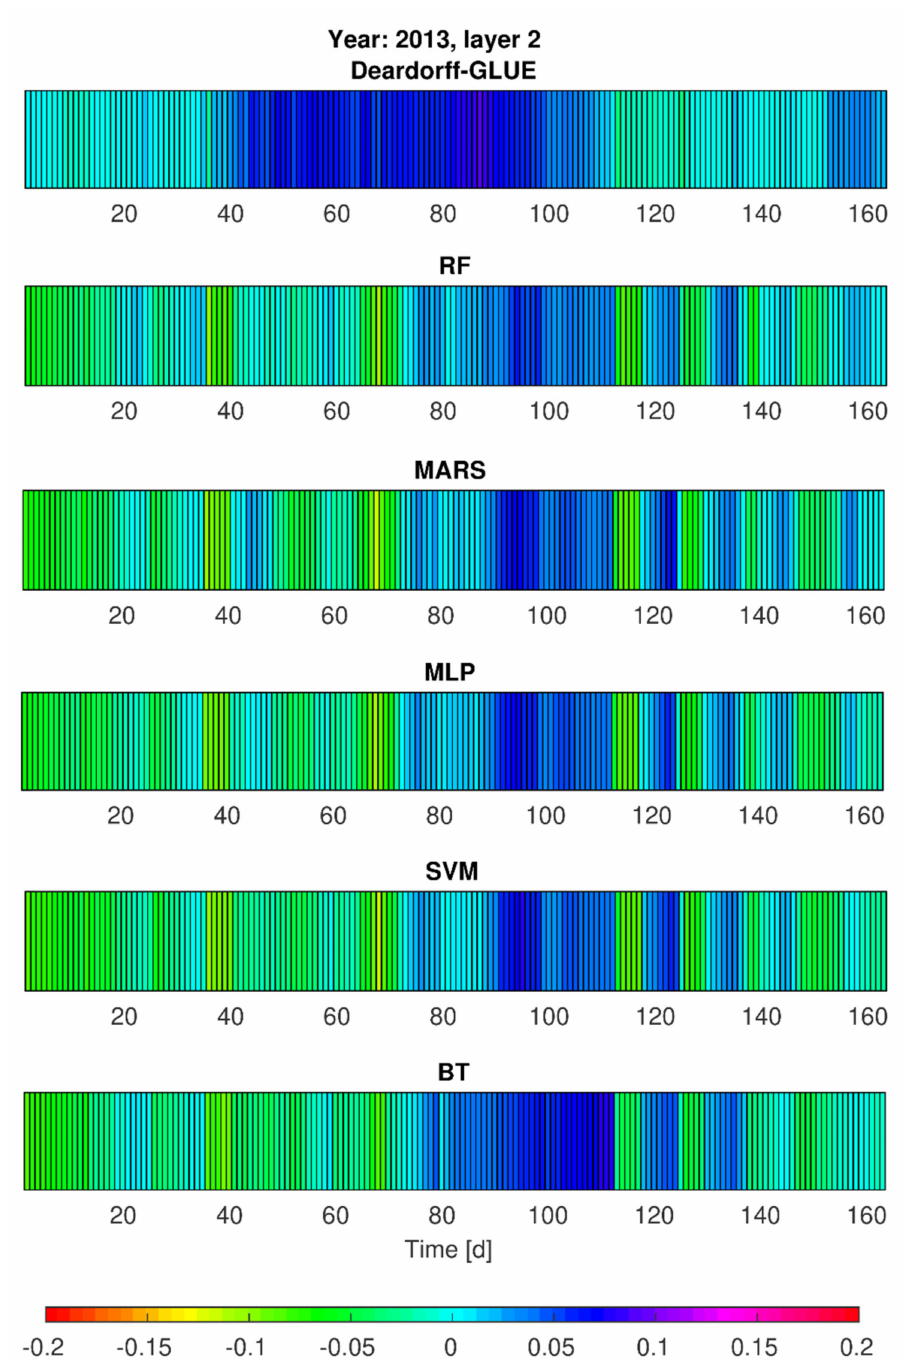
Figure 8. Error variability of soil moisture content forecast w 2 (second layer) by Deardorff model and statistical methods (BT, RF, SVM, MLP, MARS) for